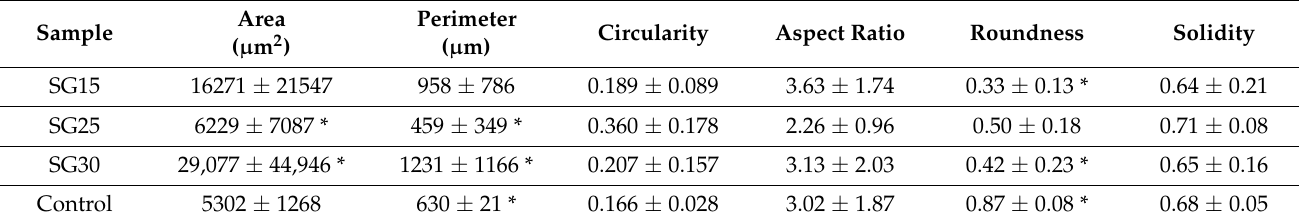
Table 5. Shape variables. Data quantified in Image J. Significant differences between groups are denoted by * ( p <